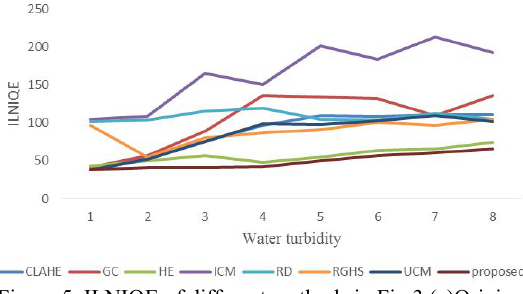
Figure 5. ILNIQE of different methods in Fig.3 (a)Original